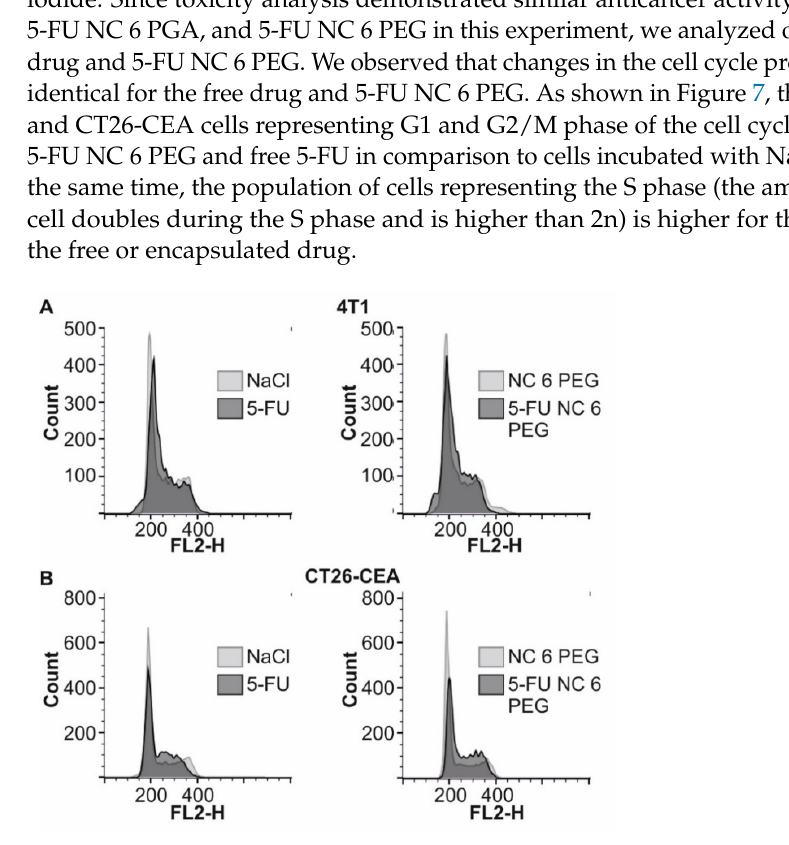
Figure 7. Changes in the cell cycle progression induced by free or encapsulated 5-fluorouracil. 4T1 cells ( A ) and CT26-CEA cells ( B ) were exposed for 48h to free 5-fluorouracil or 5-FU NC 6 PEG. Next, the cells were collected from plates, stained with PI, and the flow cytometry analysis was performed to analyze the changes in the cell cycle. Results represent three independent experiments.